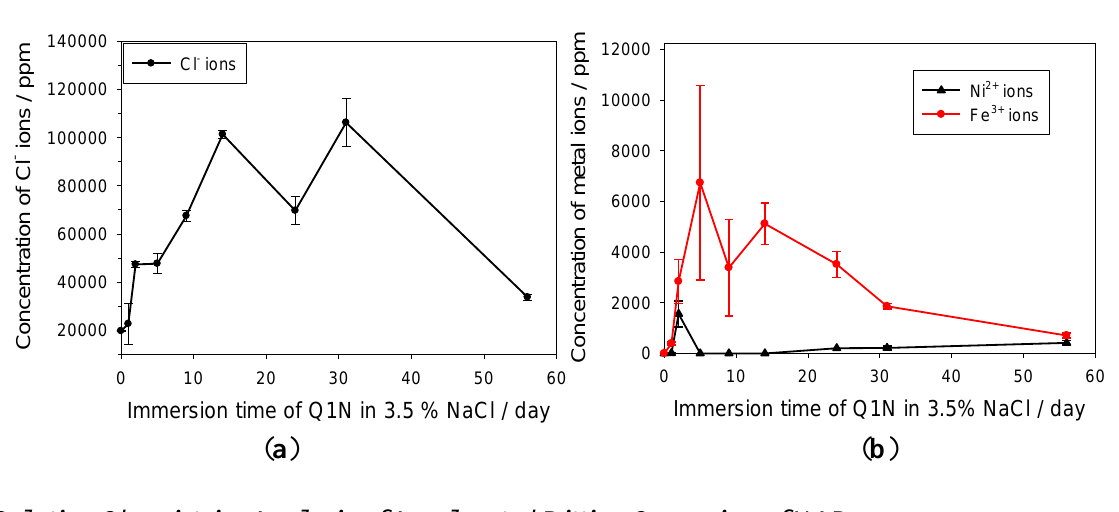
Figure 7. Concentration profiles of ( a ) chloride; ( b ) ferric and nickel ions as a function of immersion time for Q1N in 3.5% NaCl